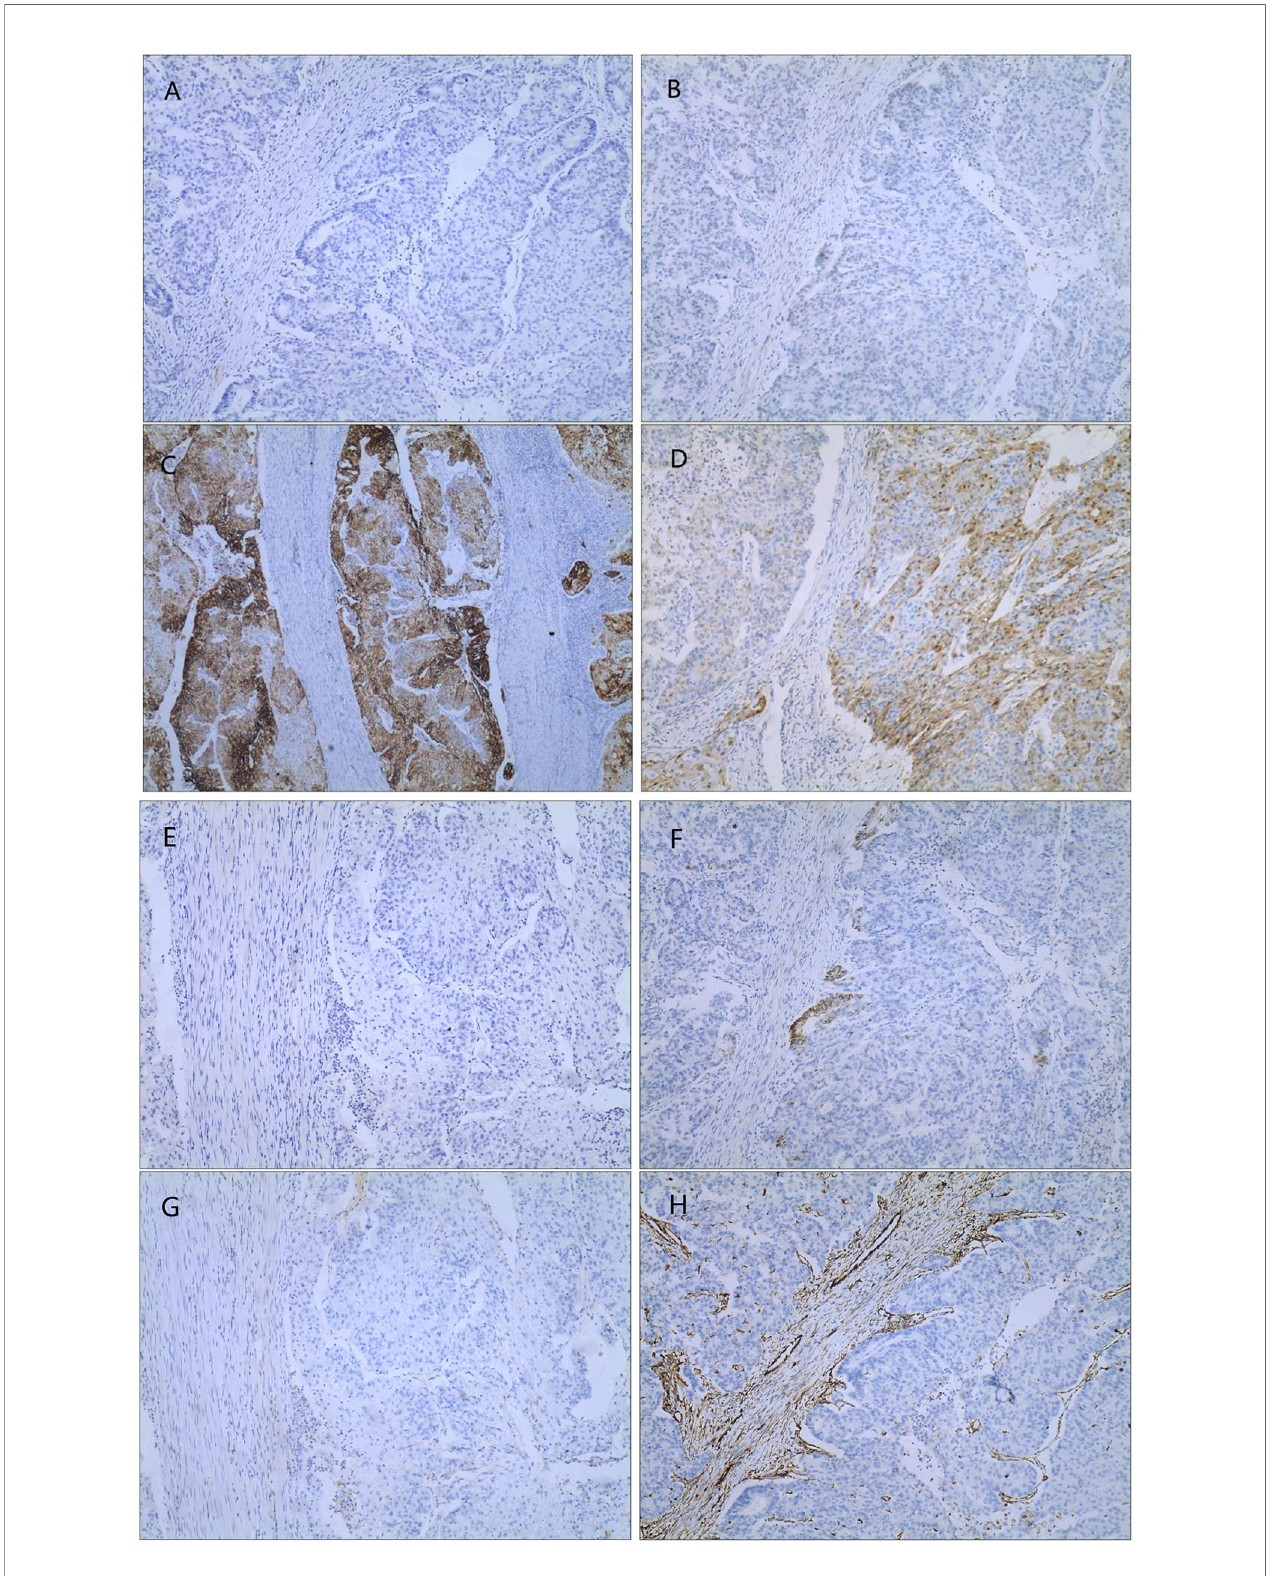
FIGURE 5 | IHC(X10): (A) CDX-2( − ); (B) ER(+); (C) CK7(+); (D) P16(+); (E) P40( − ); (F) PR(+); (G) P63( − ); (H) Vimentin( −